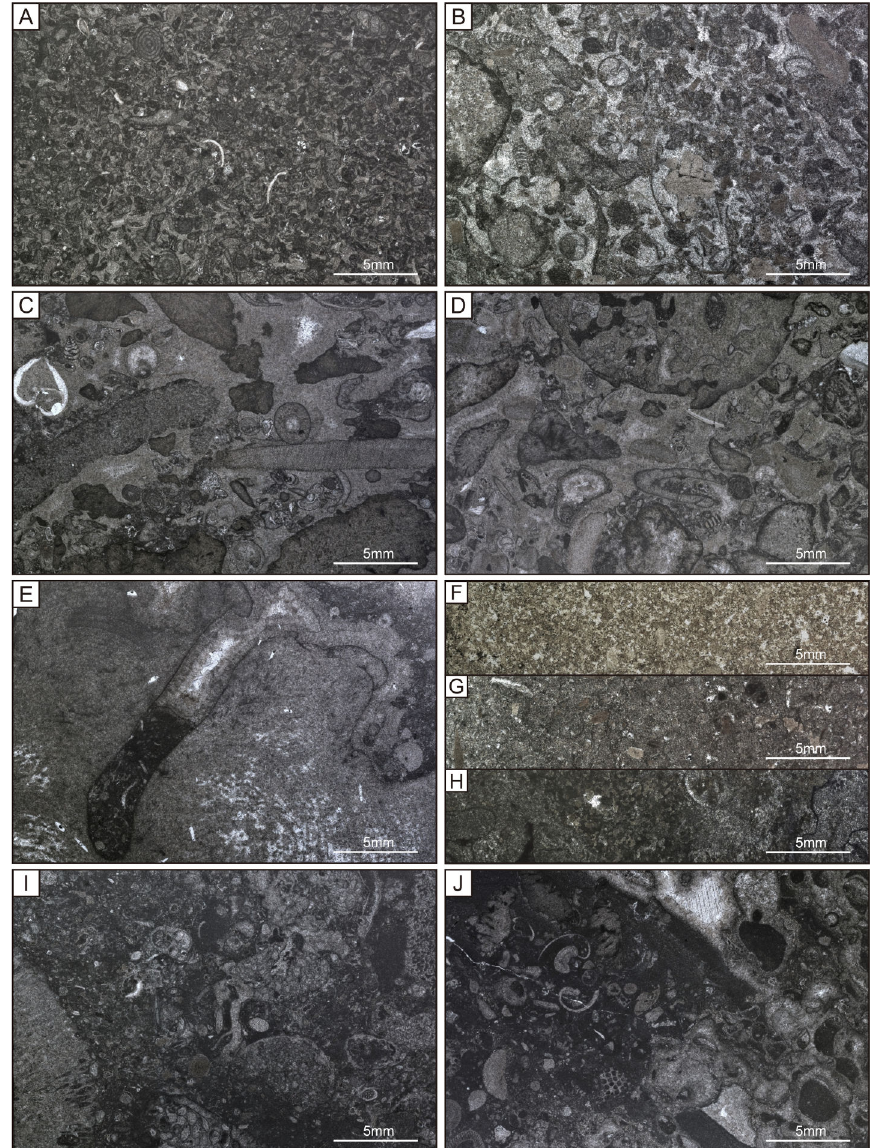
Figure 10. Photomicrographs of microfacies: ( A ) microfauna packstone; ( B ) bioclastic rudstone; ( C , D ) matrix of reef-bank shell limestone with abundant benthic fauna; ( F ) surface of reef cap; lower part of the burrowing hole filled by limestone and the upper part filled by calcite cement; ( F – H ) reef cap under different degree of dolomitization; ( I , J ) benthic organisms